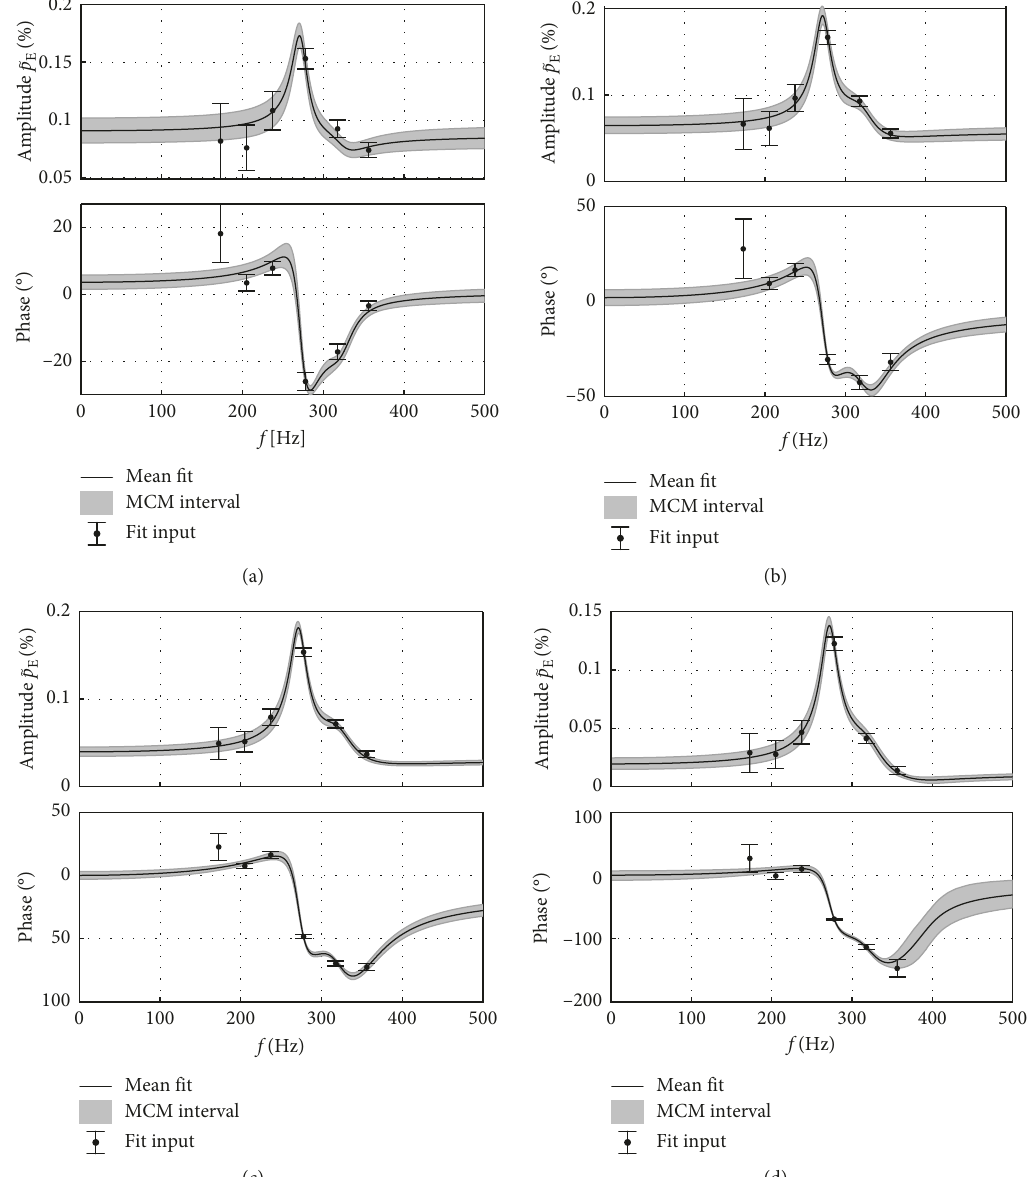
Figure 14: Least square fitting of the pressure measurements. (a) R1. (b) R2. (c) R3. (d)